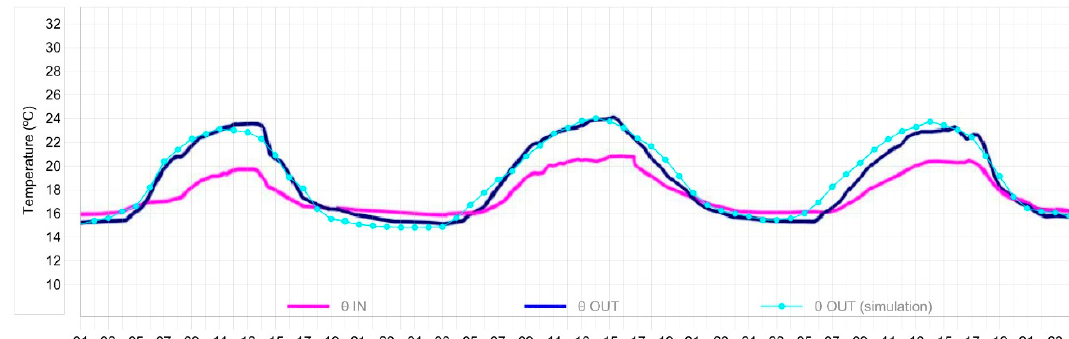
Figure 8. Comparison between measured data of the inlet and outlet temperature of the WFG cabin and results from simulation data. Sample summer days: 23/08/2010, 24/08/2010, and 25/08/2010.